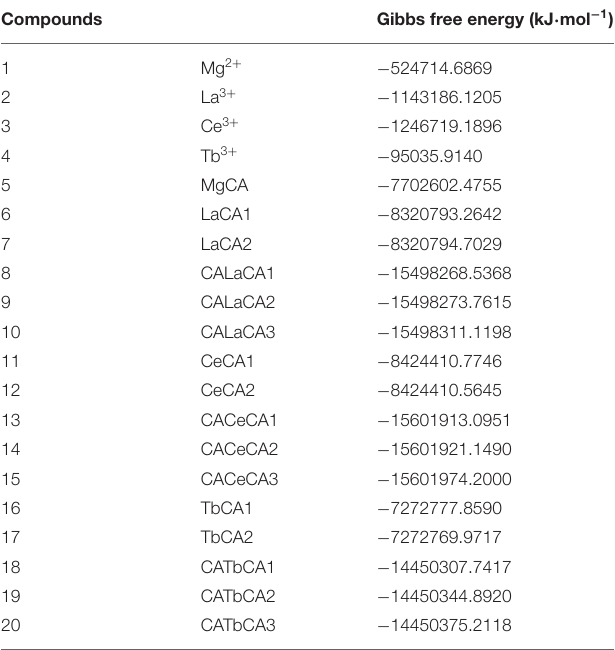
TABLE 1 | Gibbs free energies of optimized structures.